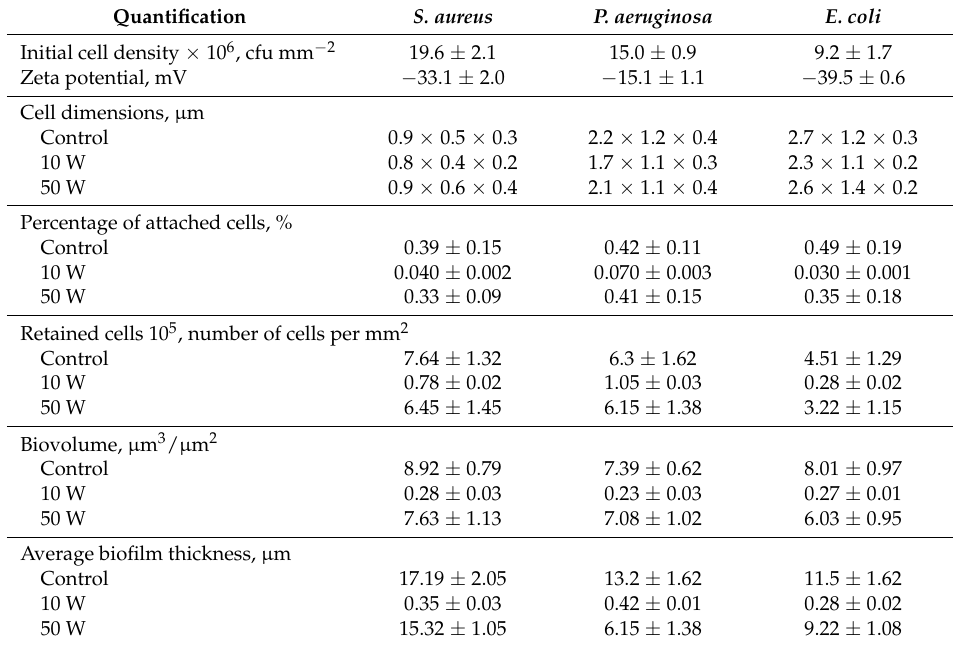
Table 7. Comparative evaluation of bacterial attachment and retention on geranium oil-based polymer film surfaces fabricated at different RF